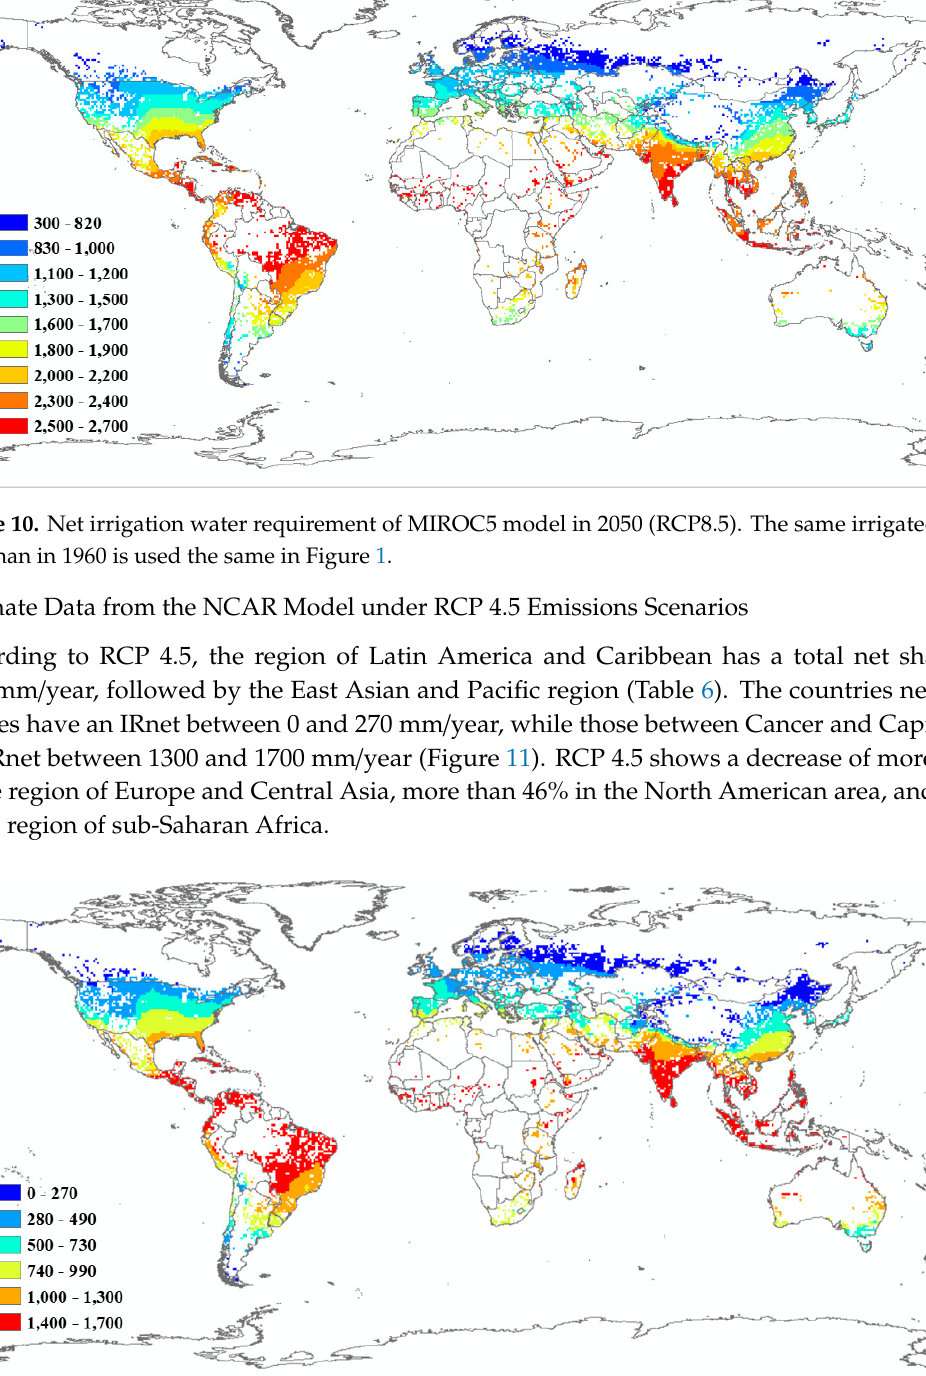
Figure 12. Net irrigation water requirement of NCAR model in 2050 (RCP8.5). The same irrigated area than in 1960 is used the same in figure 1.